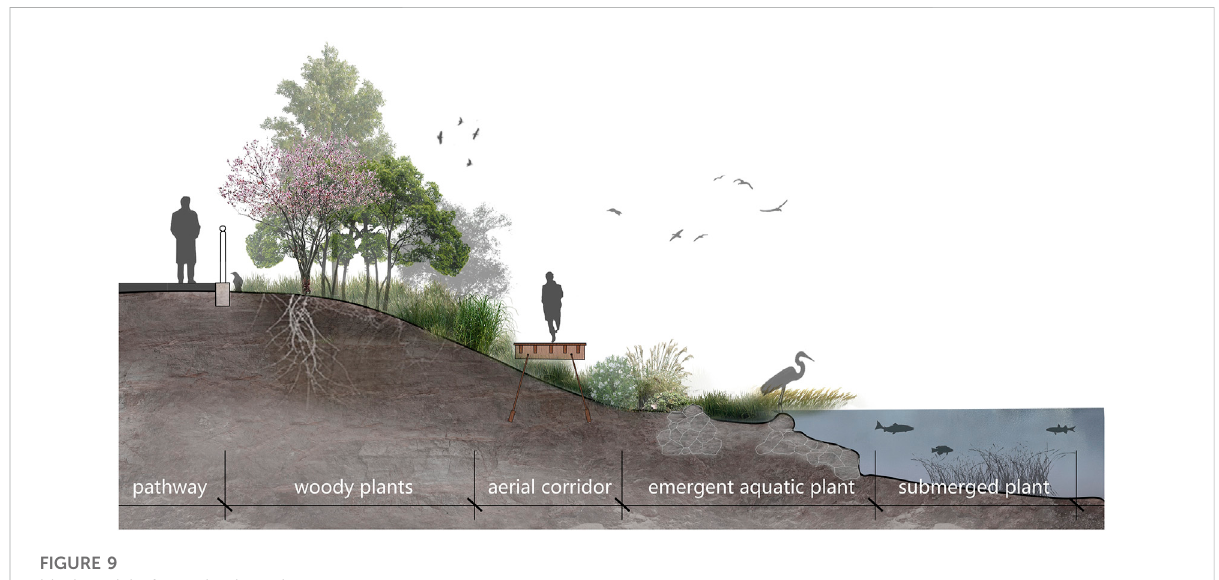
FIGURE 9 Ideal model of a wetland